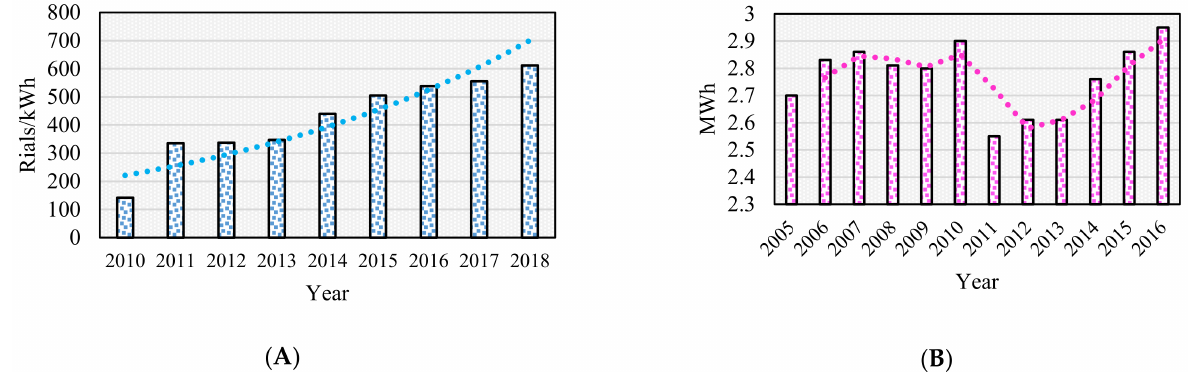
Figure 28. The increase in electricity price in Iran ( A ) and the effect on domestic electricity use per household ( B ).